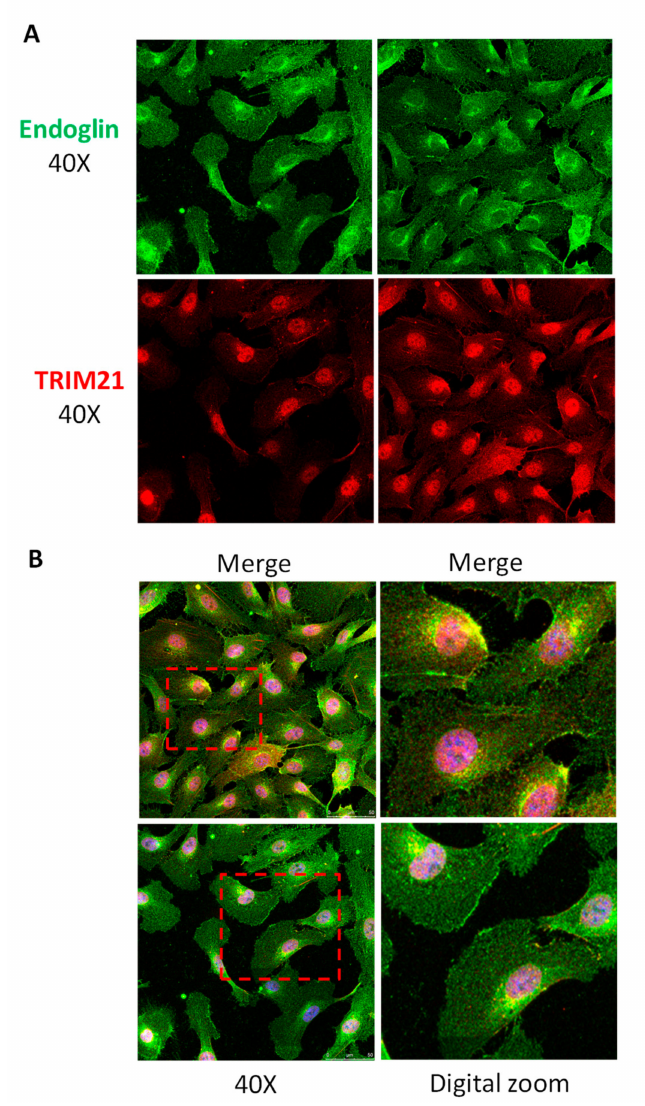
Figure 4. TRIM21 and endoglin co-localize in human endothelial cells. HUVEC monolayers were fixed with paraformaldehyde, permeabilized with Triton X-100, incubated with the mouse mAb P4A4 anti-endoglin, washed and incubated with a rabbit monoclonal anti-TRIM21 antibody (#92043). TRIM21 and endoglin were detected by immunofluorescence upon incubation with Alexa 647 goat anti-rabbit IgG (red staining) and Alexa 488 goat anti-mouse IgG (green staining) secondary antibodies, respectively. ( A ) Single staining of TRIM21 (red) and endoglin (green) at the indicated magnifications. ( B ) Merge images plus DAPI (nuclear staining in blue) show co-localization of TRIM21 and endoglin (yellow color). Representative images of four di ff erent experiments are